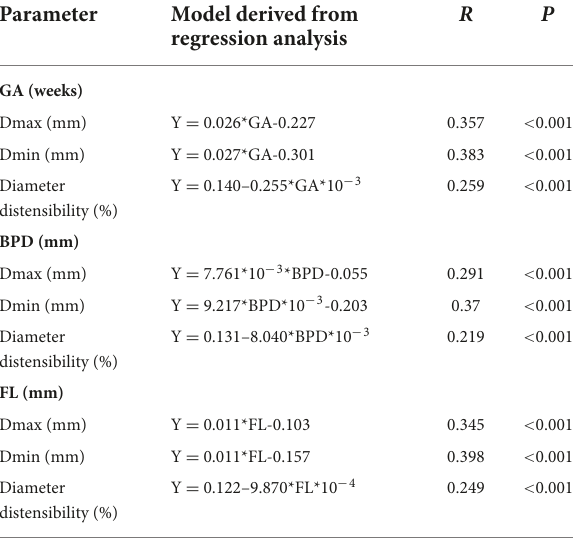
TABLE 3 Regression models for the prediction of the SD of Dmax, Dmin, and diameter distensibility based on GA, BPD, and FL. Parameter Model derived from regression